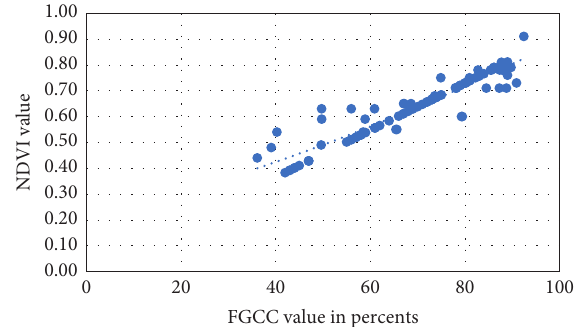
Figure 5: Approximation of the polynomial model for FGCC into NDVI conversion for winter